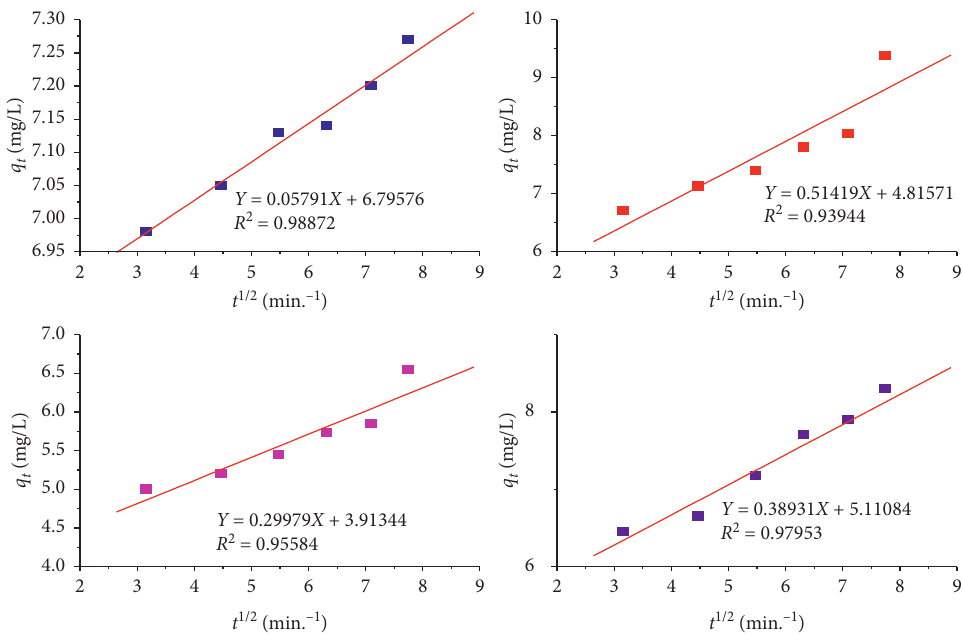
Figure 11: Intraparticle diffusion model (a) for ALAPW and (b) for RLAPW at different contact times